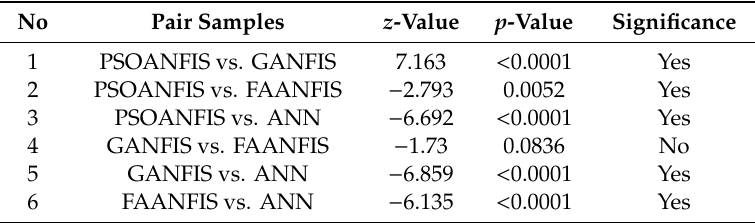
Figure 8. Correlation results analysis of the models using the testing dataset: ( a ) PSOANFIS, ( b ) GANFIS, ( c ) FAANFIS, ( d ) ANN. Table 4. Non-parametric test using training dataset.